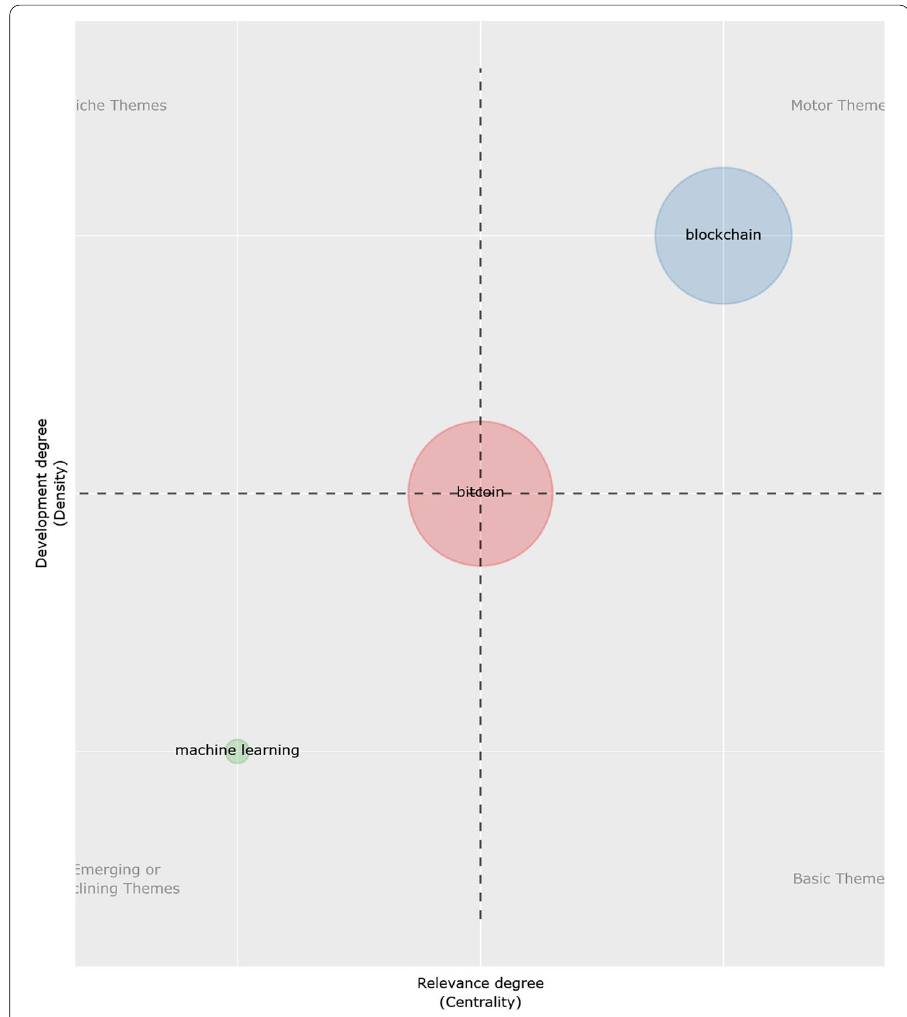
Fig. 14 Thematic map using porter’s derivation algorithm method. Source : Own